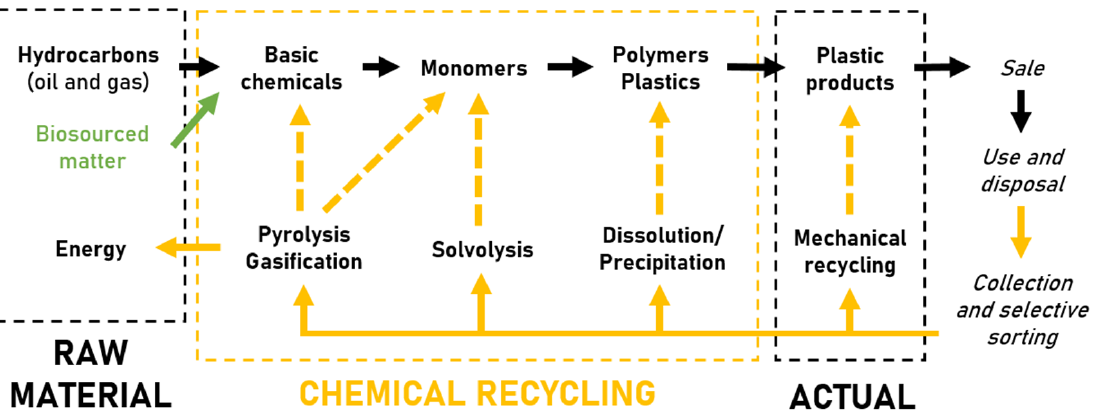
Figure 2. Schematic representation of the different existing methods for plastic waste recycling and their implementation in the circular economy.